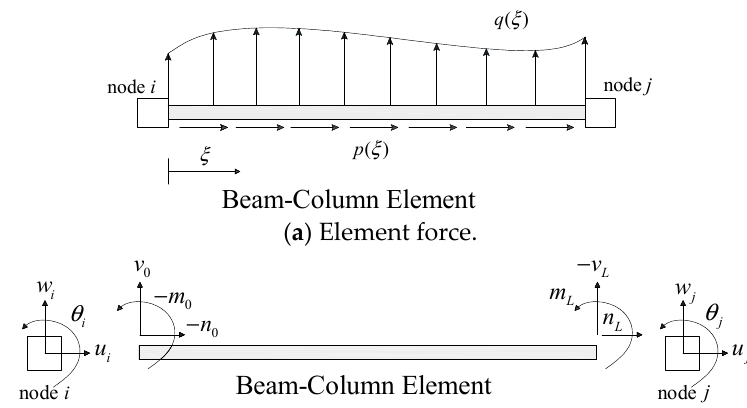
Figure 4. Beam-column element.